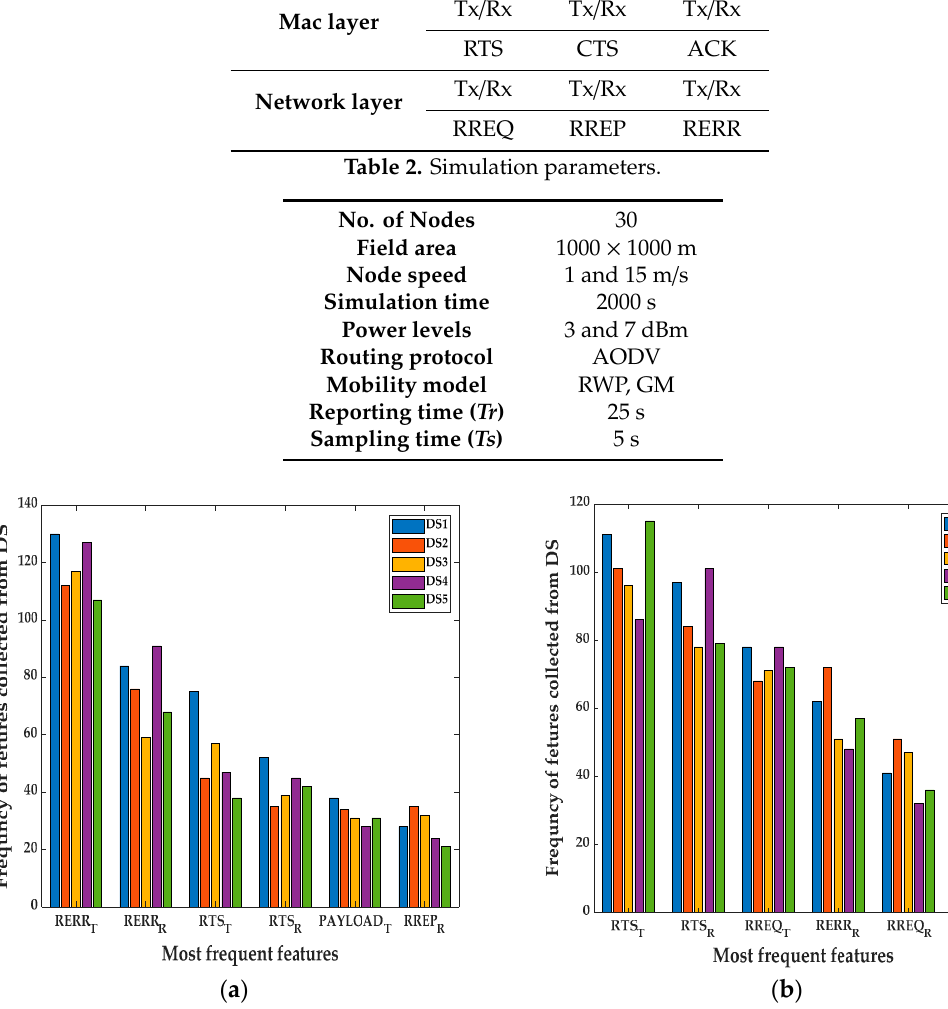
Table 1. Cross layer features.